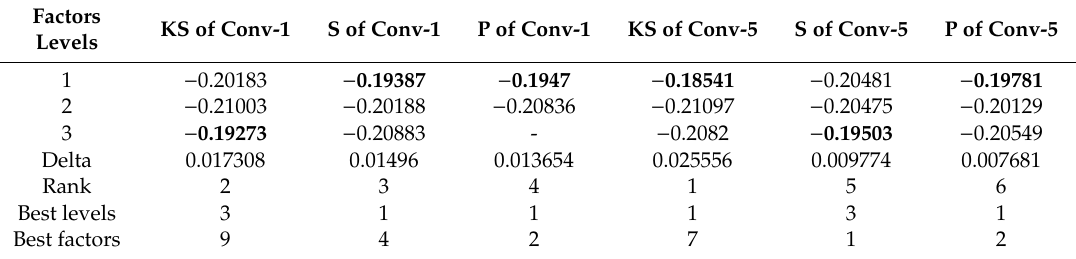
Table 9. Average S / N ratio of each factor and level in MORPH